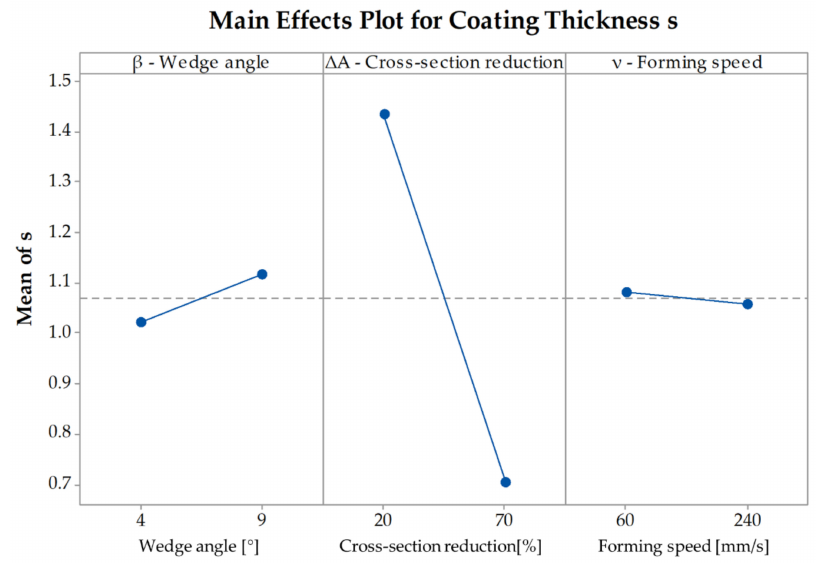
Figure 8. Main E ff ects Plot for the coating thickness s in the